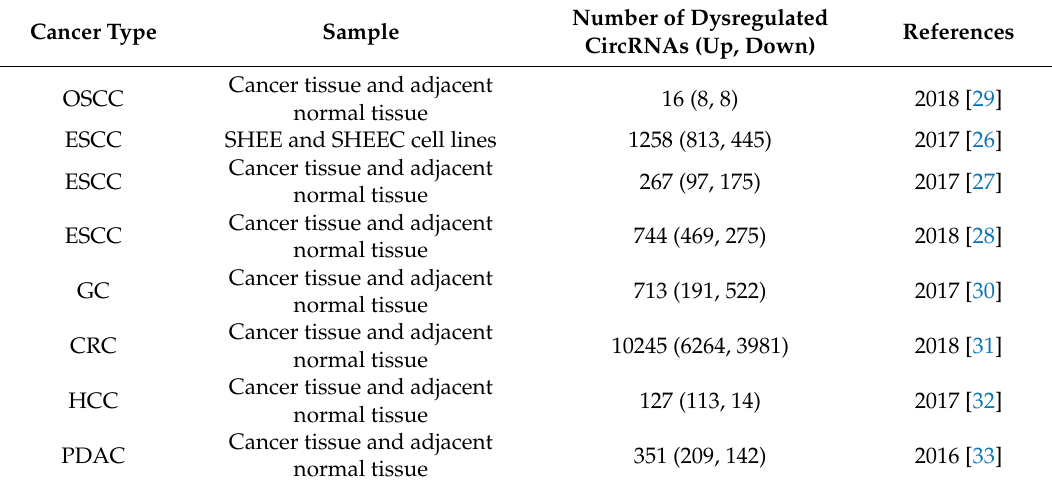
Table 1. Overview of di ff erentially expressed circRNAs identified in digestive system